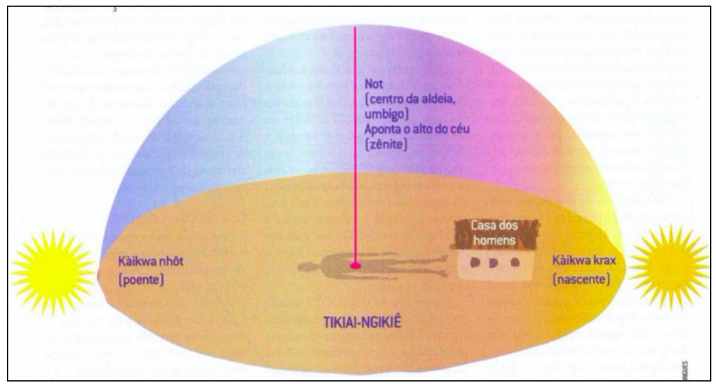
Figure 4. Kayap ó orientation. Source: Campos, [13] (p.